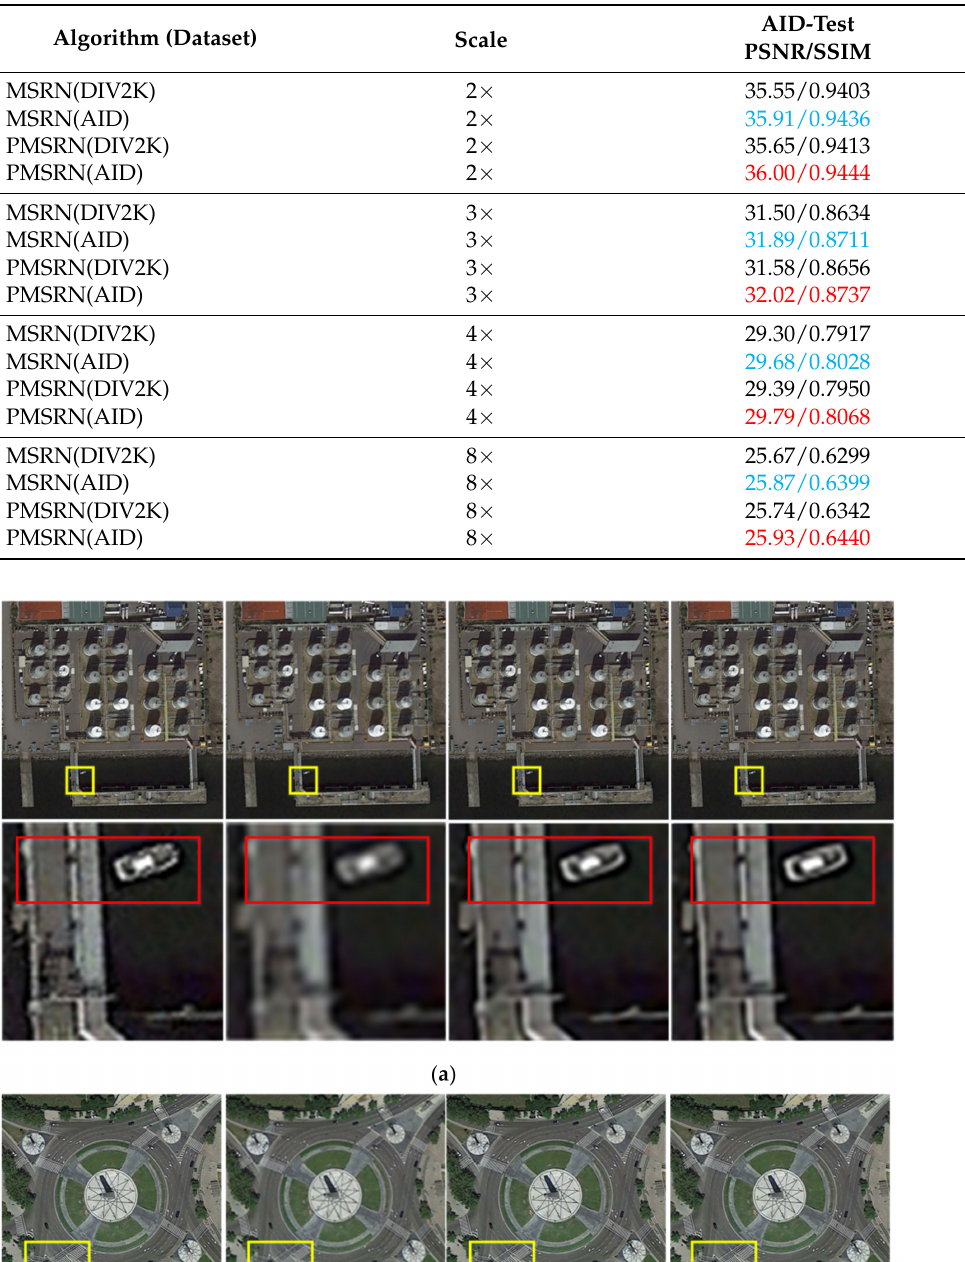
Table 4. Comparison of SR image evaluation results of different training set reconstruction models. The numbers in red and blue represent optimal and suboptimal values, respectively.